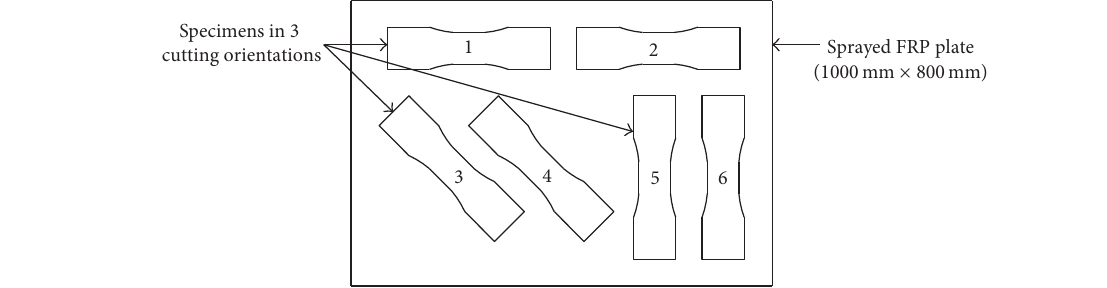
Figure 5: Specimen cutting orientation.